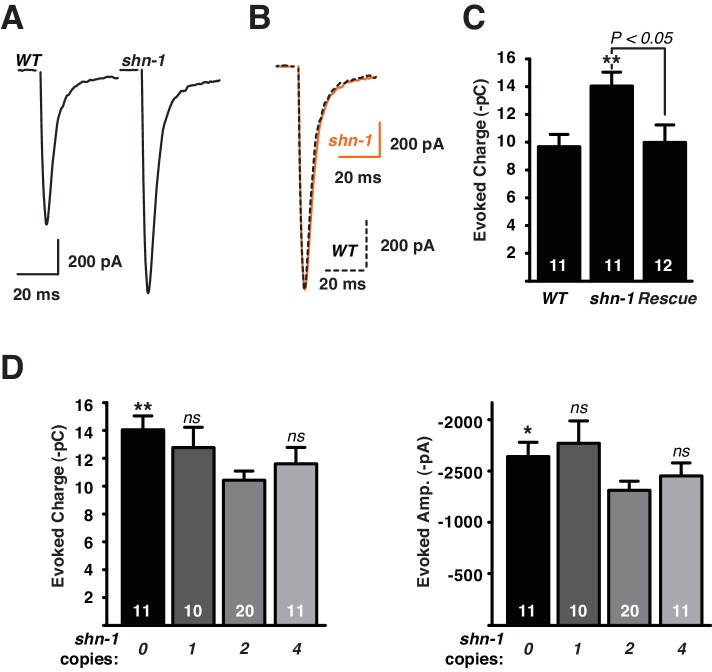
Synaptic transmission at the NMJ is not sensitive to shn-1 gene dosage.Stimulus-evoked EPSCs were recorded from adult body wall muscles. Representative traces of evoked responses (A), averaged shn-1 and WT evoked responses (normalized to equal amplitudes) (B), and mean evoked charge transfer (C) are shown. Evoked charge was significantly increased in shn-1 homozygotes and this defect was rescued by a single copy transgene (nuSi26) that restored SHN-1 expression in body muscles (C). Averaged peak normalized shn-1 and WT evoked responses have indistinguishable rise and decay times, indicating that rise and decay kinetics were unaltered (B). Evoked charge transfer (D) and peak amplitudes (E) did not differ significantly in animals containing 1, 2, and 4 shn-1 copies. The number of animals analyzed is indicated for each genotype. Values that differ significantly from wild type controls are indicated (**p<0.01; ns, not significant). Error bars indicate SEM. Mean, standard errors, sample sizes, and p values for this figure are shown in Supplementary file 1.